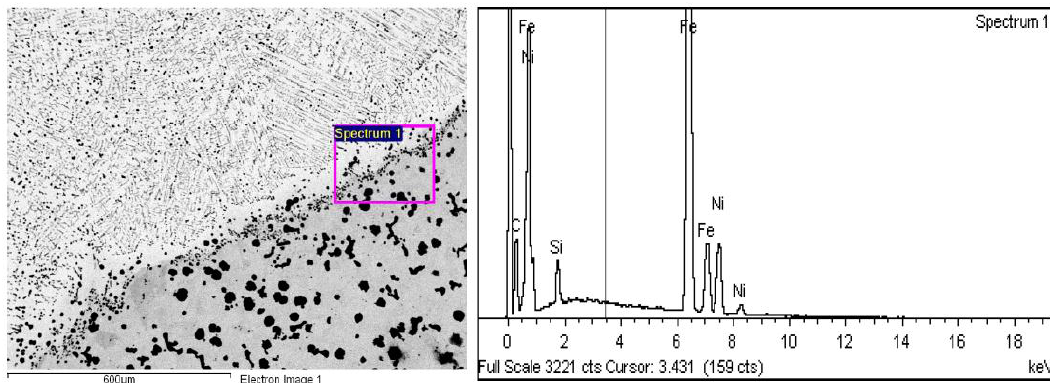
Figure 12. This figure shows micrographic and spectrum images of the filler weld interface of the top pass (electrode 97.6% Ni) and with a heat treatment at 900 °C. A higher content of free carbon is observed due to the dissolution of the white iron traces, while Cr is barely detectable (meaning greater ductility and less hardness).